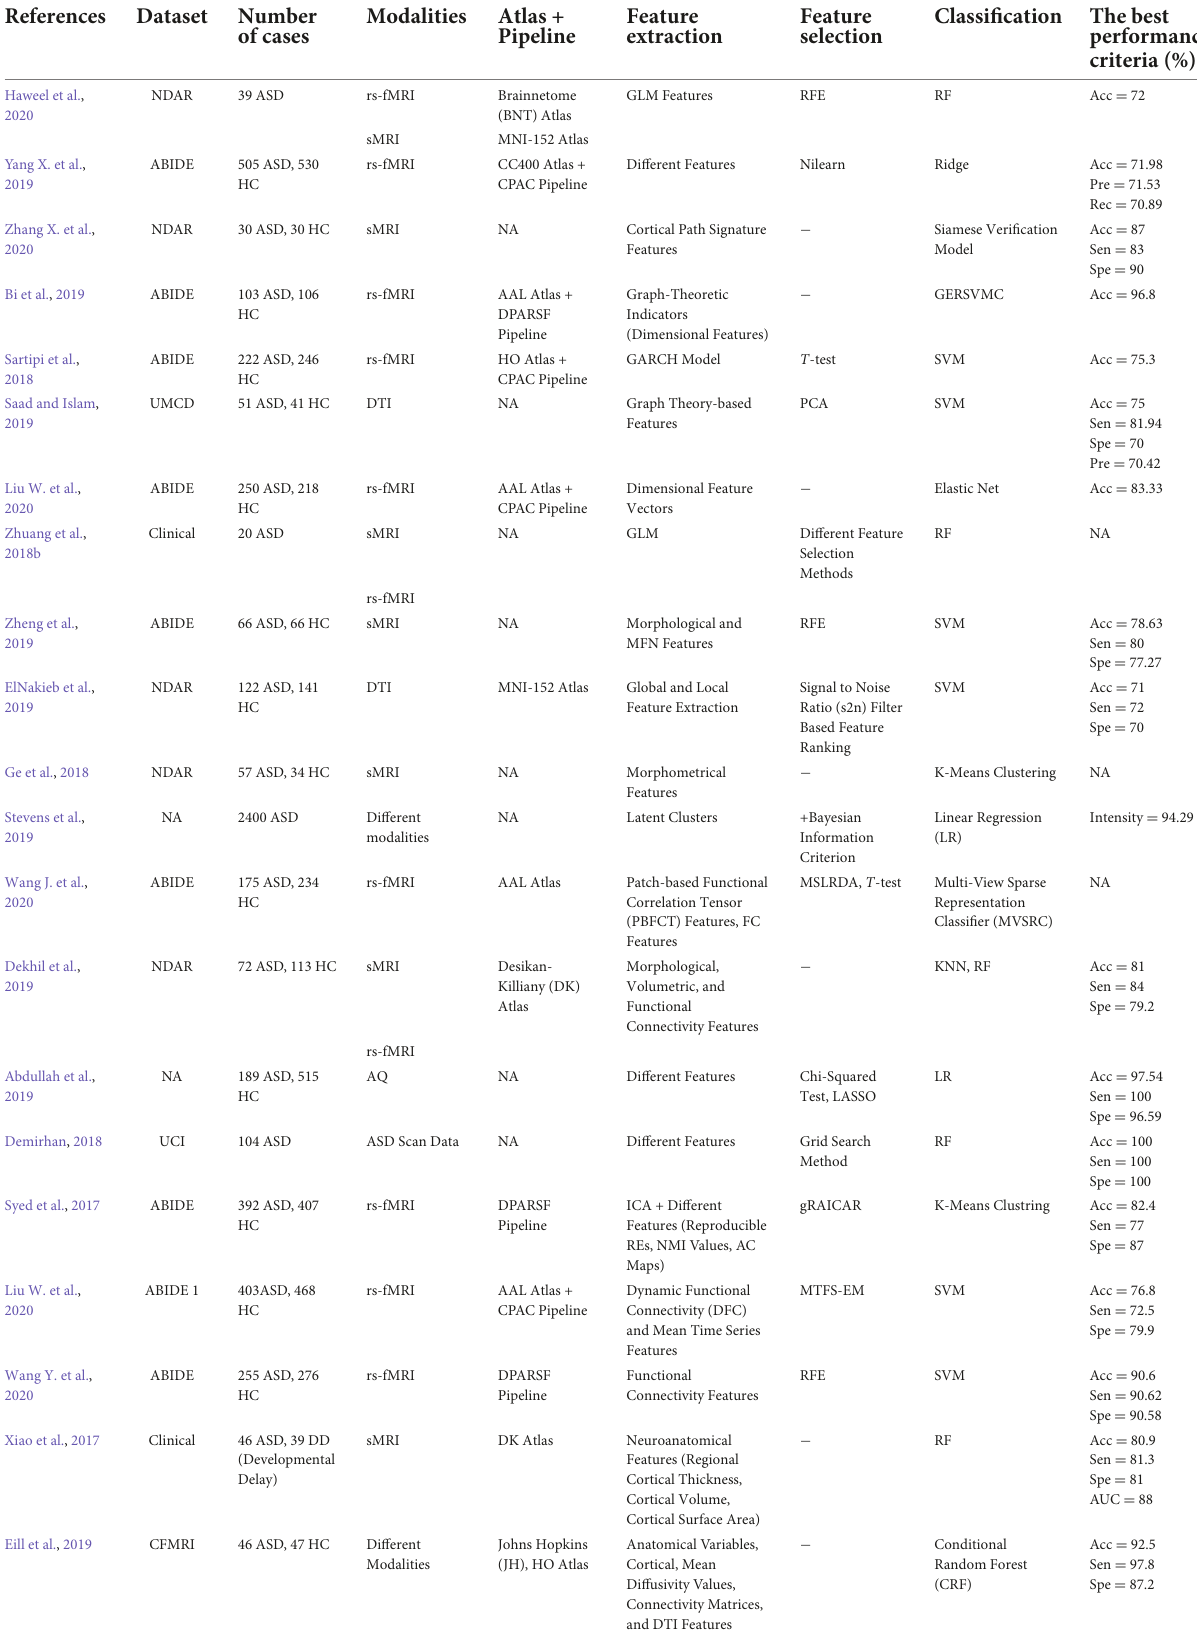
TABLE 2 Automated diagnosis of ASD with MRI neuroimaging modalities using ML